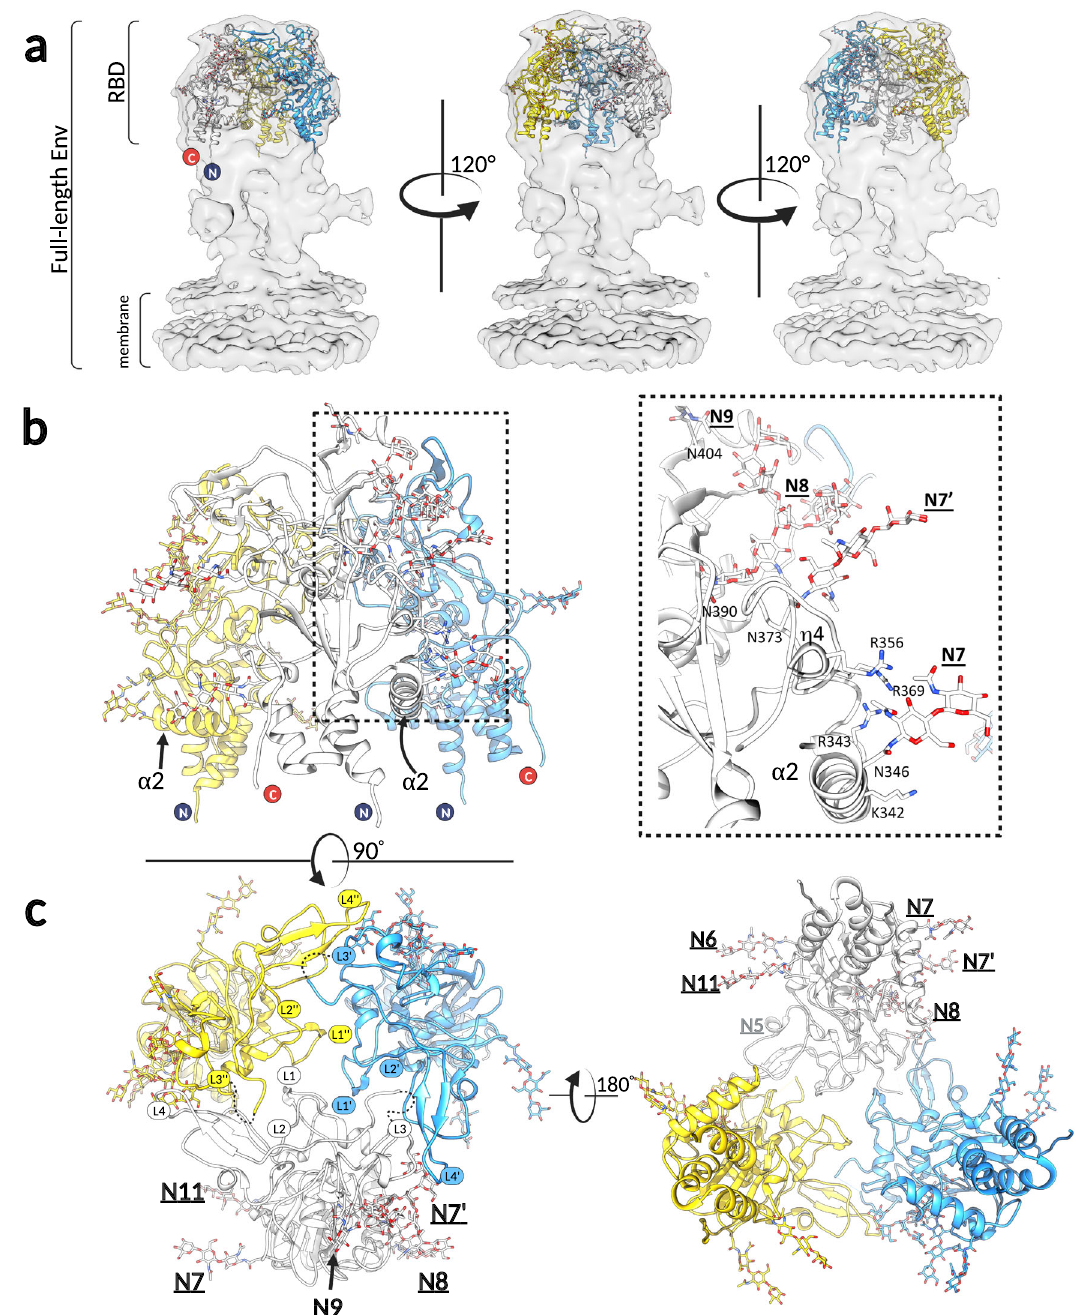
Fig. 4 | The RBDs form a trimeric assembly at the apex of the full-length Env. a Three SFV RBD D protomers were fi tted in the 9Å cryo-EM map (EMBD: 4013) obtained by cryo-EM 3D reconstruction of the full-length PFV Env expressed on viralvectorparticles 13 . Themapisshowninlight graysurface,and RBDsincartoon mode, with each protomer colored differently (yellow, white, light blue). b The threeRBDs, fi ttedasexplainedinpanela,areshowntoillustratethatthe α 2and η 4 helices, which carry the HS-binding residues (K342, R343, R359, R369), and the N-linkedglycosylations(N6,N7,N7 ’ ,N8,N9andN11)pointoutwardandaresolvent